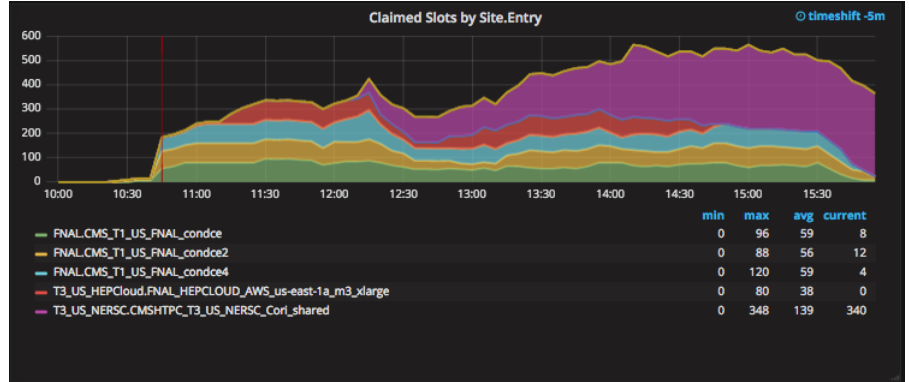
Fig. 5. Acquiring compute slots at AWS, NERSC Grid sites with the Decision